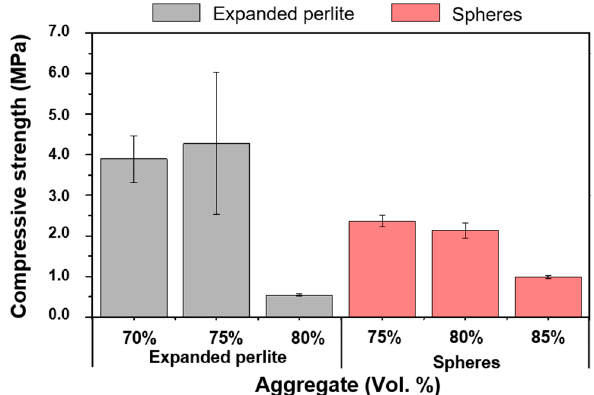
Figure 4. Compressive strength (MPa) of geopolymer composites varying the amount of expanded perlite and geopolymer spheres.